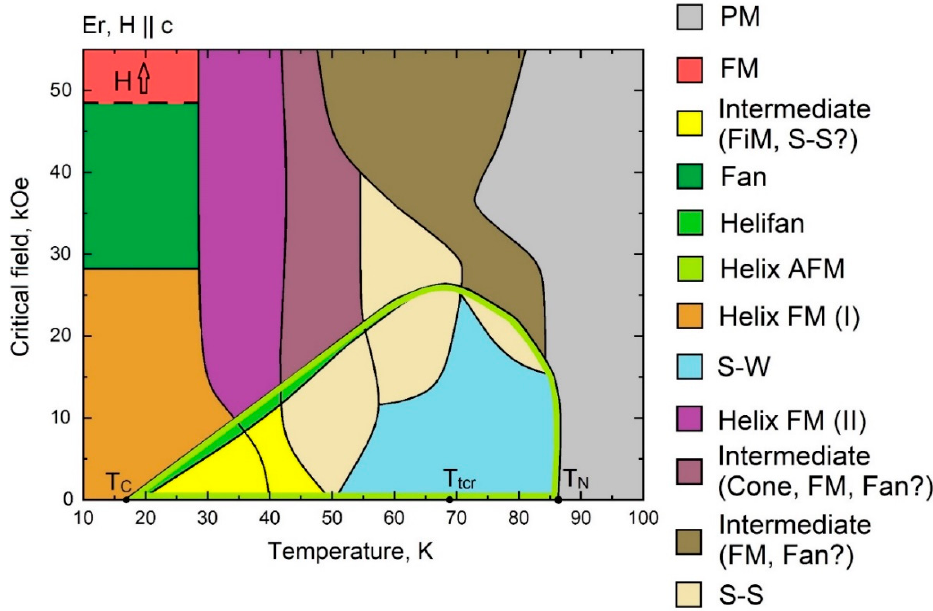
Figure 6. Magnetic phase diagram of Er. The experimental data has been taken from